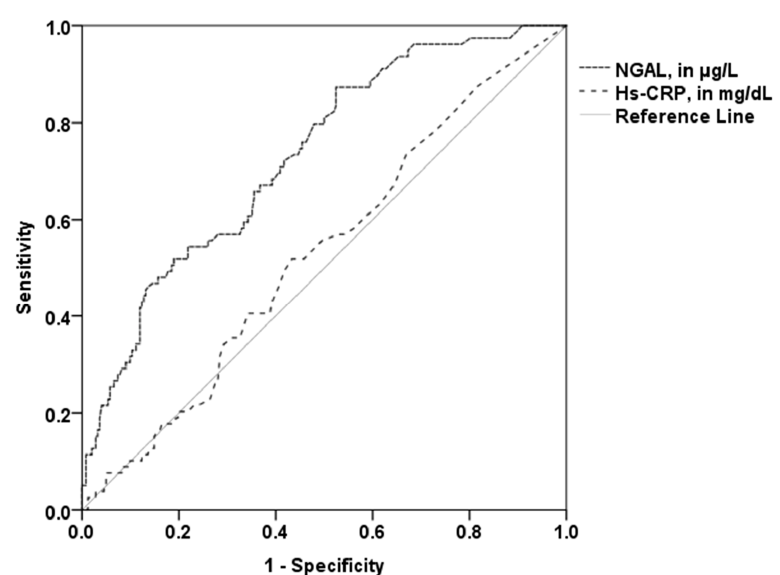
Figure 3. Receiver operating curves for the prediction of higher total PV. The AUC of NGAL (0.73) was significantly higher than the AUC of hs-CRP (0.53). NGAL—neutrophil gelatinase-associated lipocalin; hs-CRP—high sensitivity C-reactive